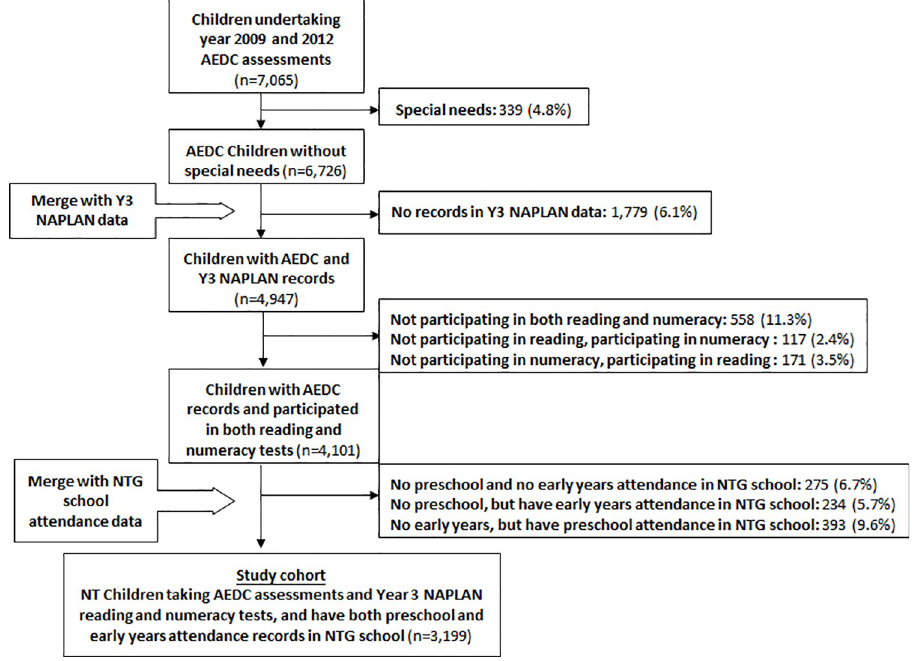
Fig 1. Flow diagram of cohort selection, NT children receiving AEDC assessments (Cycle 1 and 2 in 2009/10 and 2012).